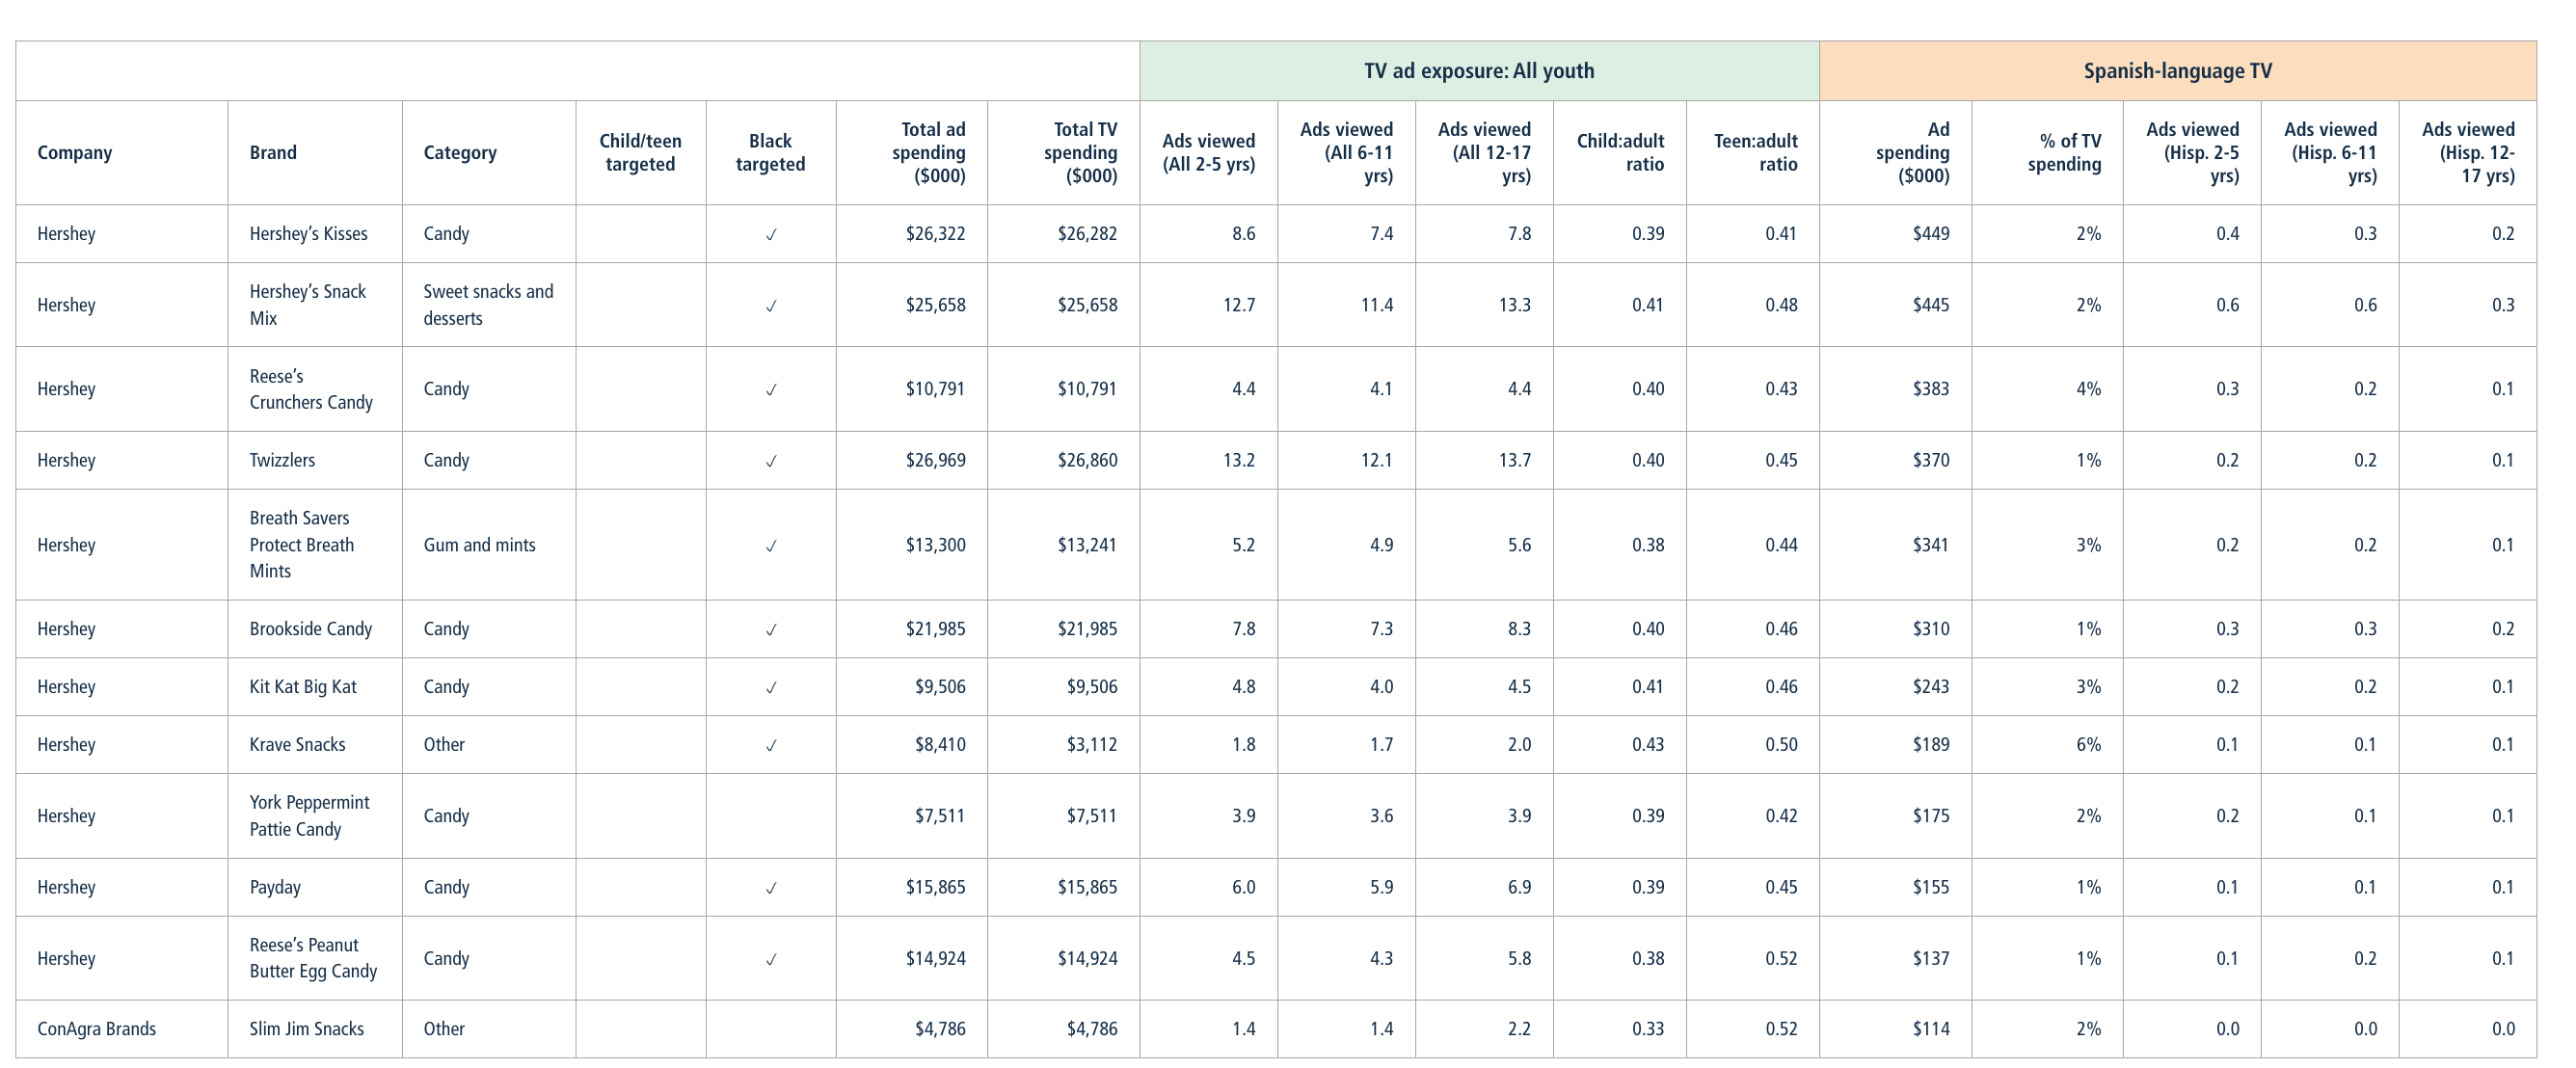
TABLE 2. BRANDS TARGETED TO HISPANIC CONSUMERS